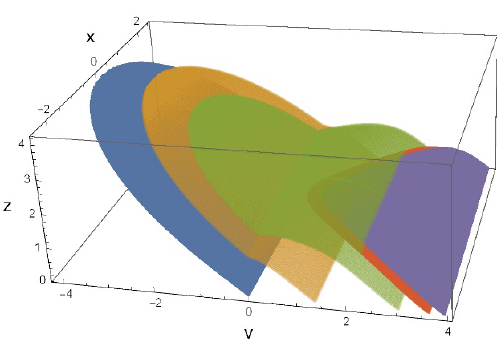
Figure 6 . The evolution of the codimension-one extremal surface (cid:0) A which characterizes the subregion complexity enclosed by the codimension-two extremal surface (cid:13) A and A . We take AdS 4 ; l = 5 ; M = 1 and v 0 = 0 : 01 here.